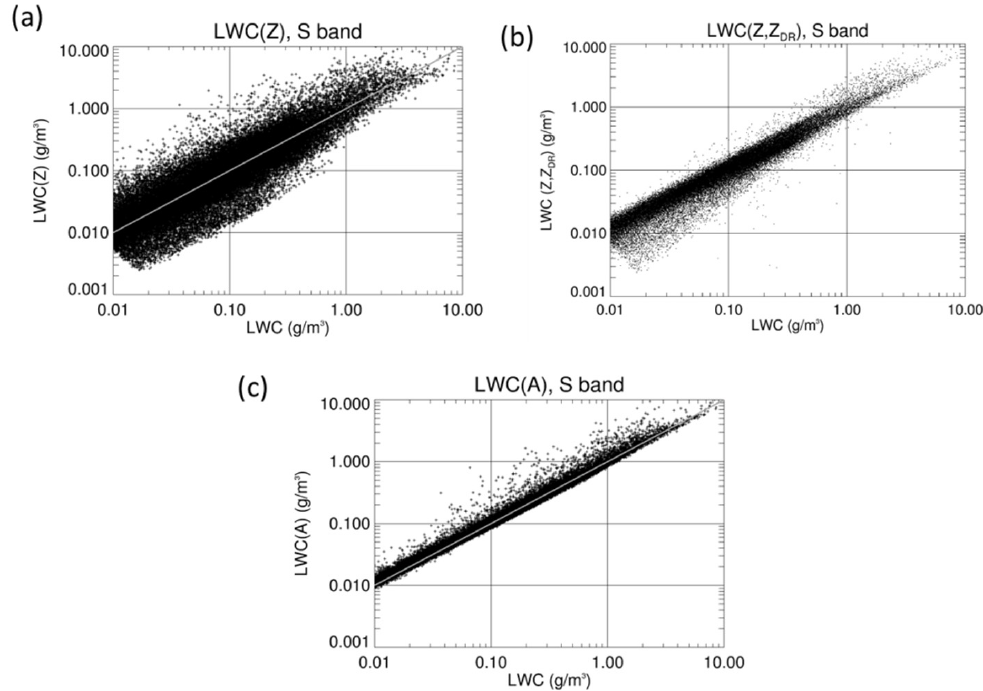
Figure 13. Scatterplots of the liquid water content (LWC) measured by the 2D video disdrometer in Oklahoma versus its estimates from ( a ) LWC(Z), ( b ) LWC(Z,Z DR ), and ( c ) LWC(A) radar relations. Owing to the monotonic relation between raindrop size and oblateness, the mean volume diameter D m of raindrops, defined as the ratio of the 4th and 3rd moments of the DSD, or median volume diameter D 0 (which is very close to D m ) are traditionally estimated from Z DR . A summary of various proposed D 0 (Z DR ) relations is provided in Chapter 11 of Ryzhkov and Zrnic [3] for di ff erent